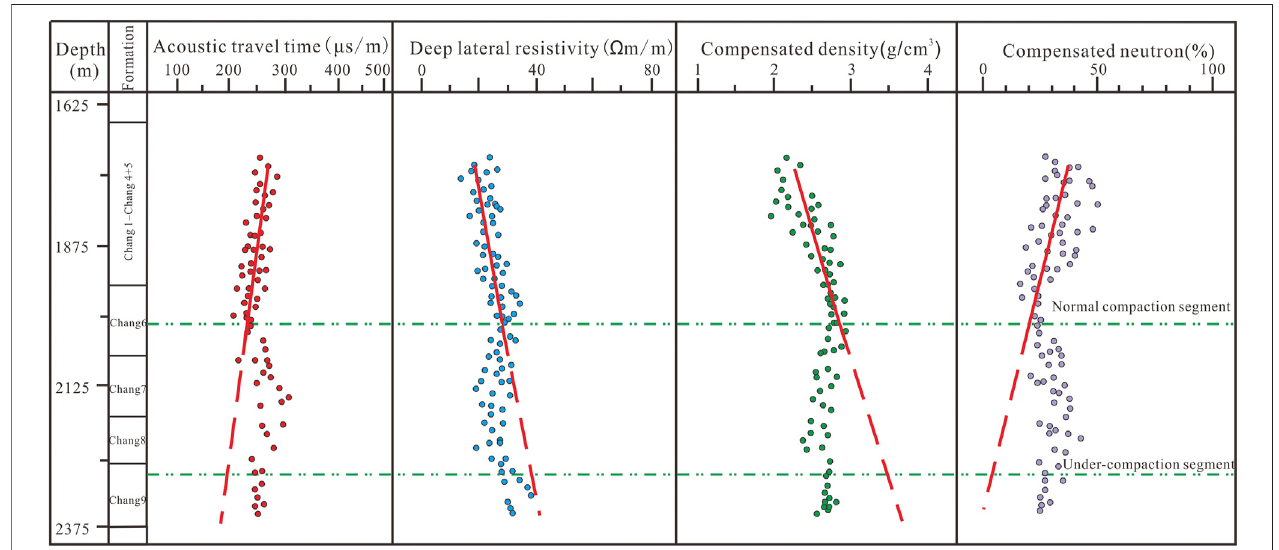
FIGURE 3 | Comprehensive compaction curve of mudstone in Well L in the Longdong